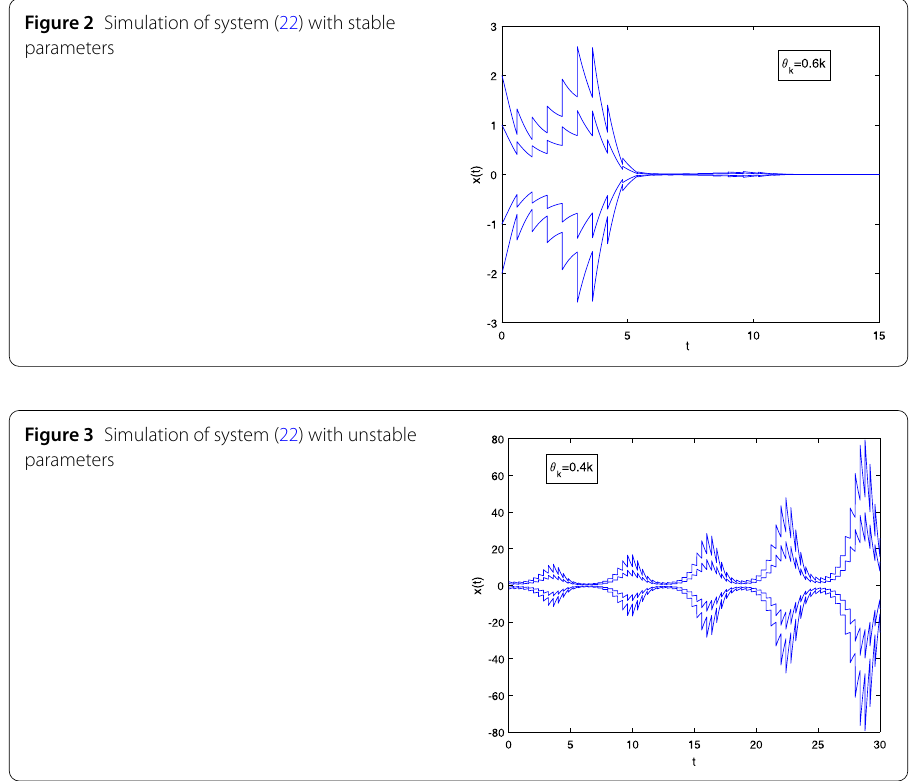
Figure 2 Simulation of system (22) with stable parameters